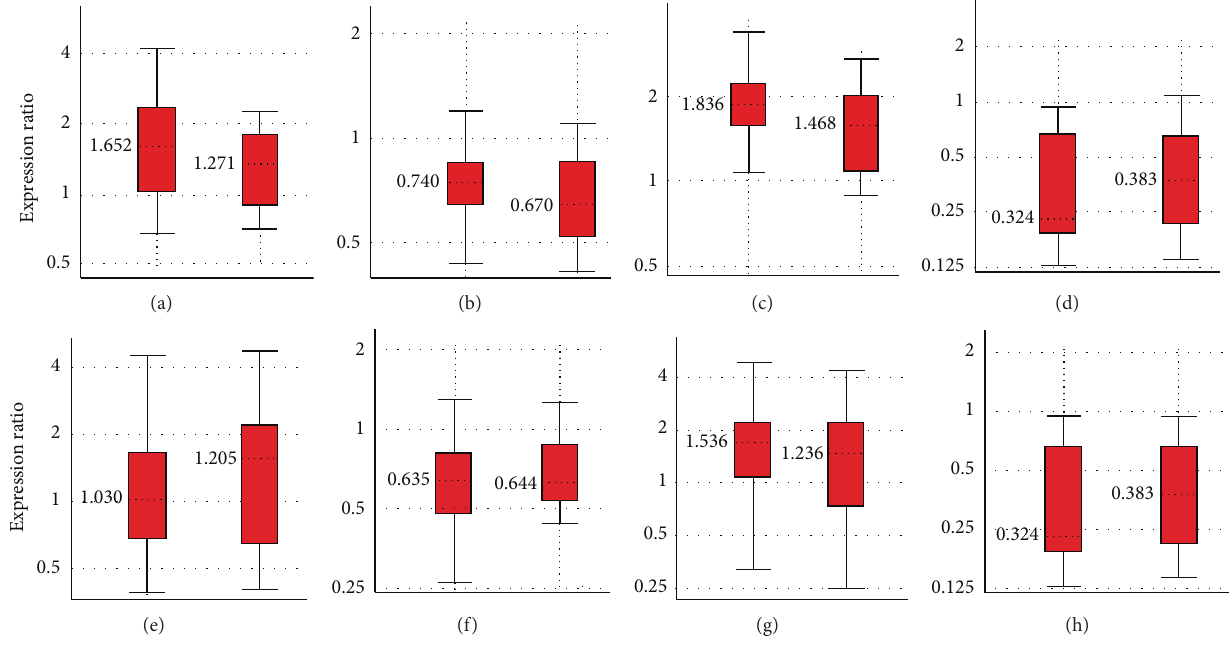
Figure 4: Relative quantification of SsPIP1 aquaporin-1 (unitag SD264077) and SoPIP1-3/PIP1-4 (unitag SD231548) with sugarcane cDNAs [tolerant genotypes: (a) CTC6, (b) CTC15, (c) SP83-2847, (d) SP83-5073; sensitive genotypes [(e) CTC9, (f) CTC13, (g) SP90-1638, (h) SP90- 3414] under stress (24h of continuous dehydration). The expression ratios of the same genotypes under control condition were normalized by reference genes GAPDH and 25S rRNA. # Relative expression (REST © v. 2.0.13 software) with the mean value (horizontally dotted line) and range of the observations (100%, horizontal bars); in red: confidence interval at